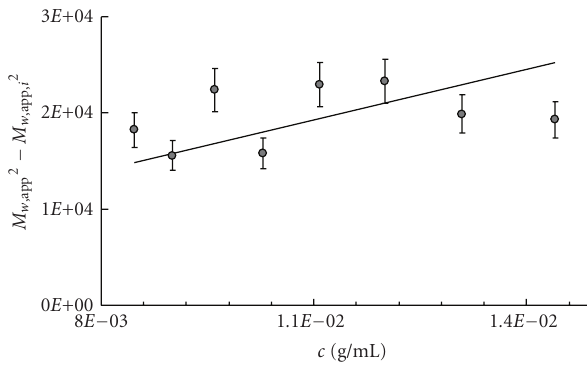
Figure 5: Determination of the equilibrium constant in the polymerization of 1 . M w ,app, i is the molecular weight of the initial monomer 1 starting the association. The guiding line shows the experimental points’ regular behaviour. From the straight line it is possible to calculate the equilibrium constant of the association K 0 = 400Lmol − 1 (error bars of